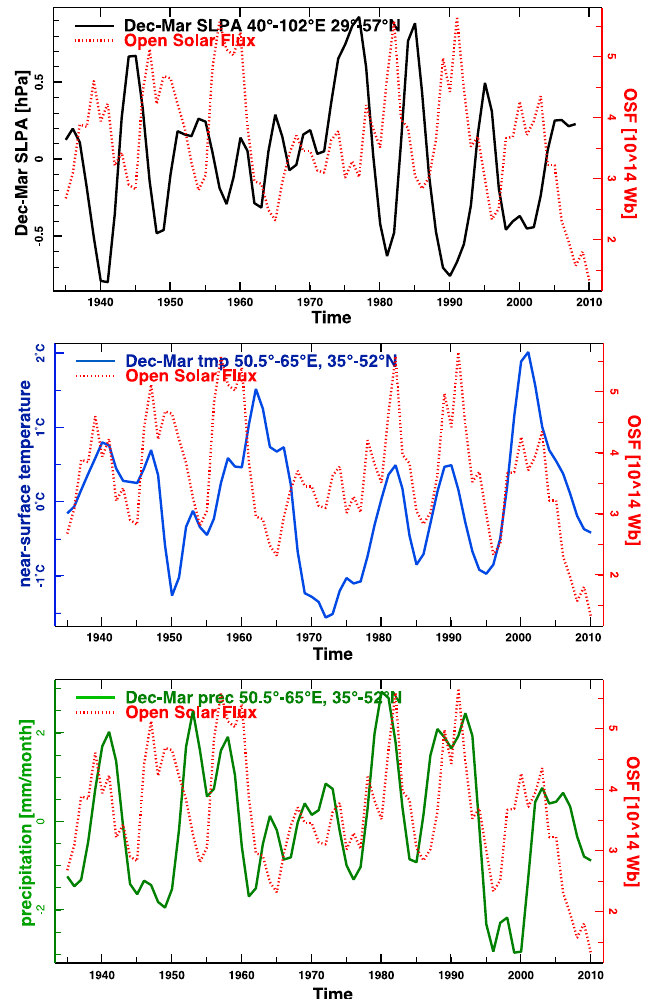
Figure 8. Decadal variations in winter (December–March) Central Asia sea level pressure in hPa ( a ), temperature in °C ( b ) and precipitation in mm/month ( c ) compared with the “11-year” cycle of Open Solar Flux in 10 14 Wb (dotted red line in all three panels). Meteorological data were averages in the domains indicated in the figures.